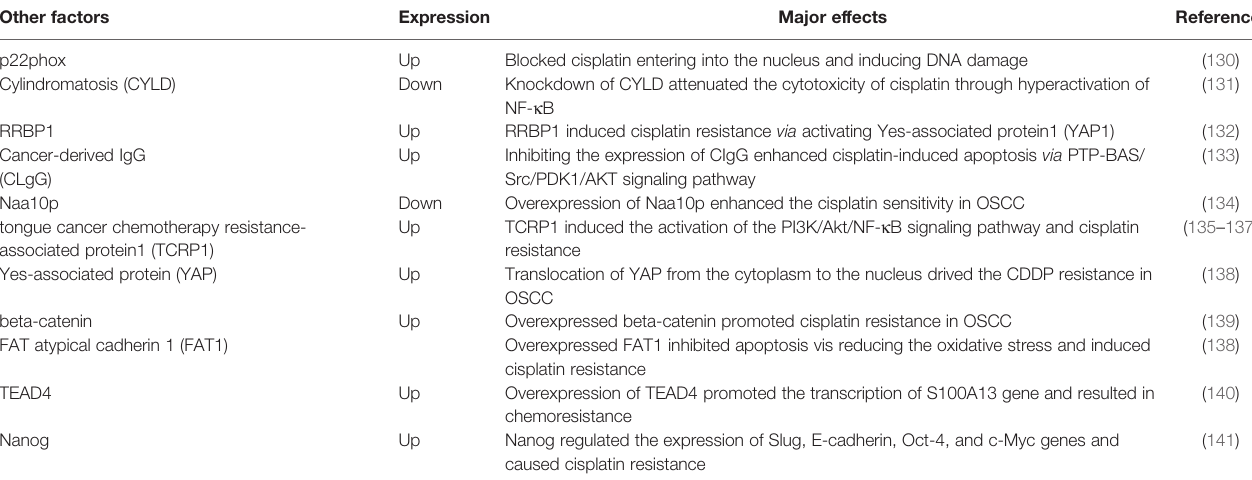
TABLE 2 | Other factors and cisplatin resistance in